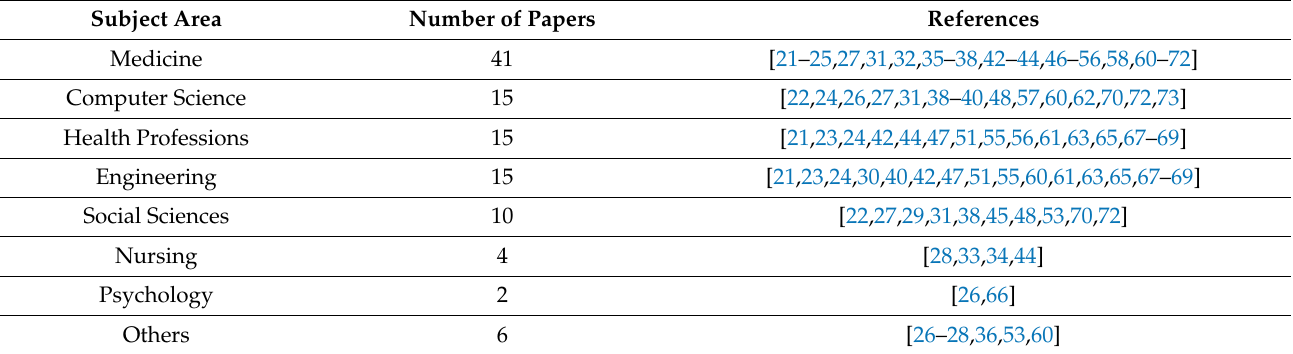
Table 3. Distribution of papers by subject area (more than one study).